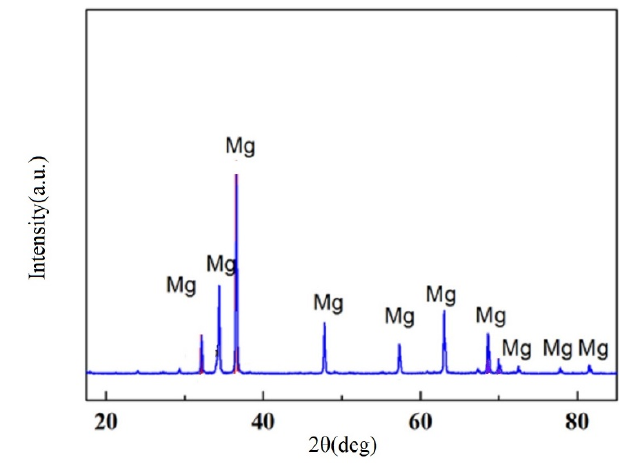
Figure 3. XRD pattern of Mg coating on a PEEK substrate.